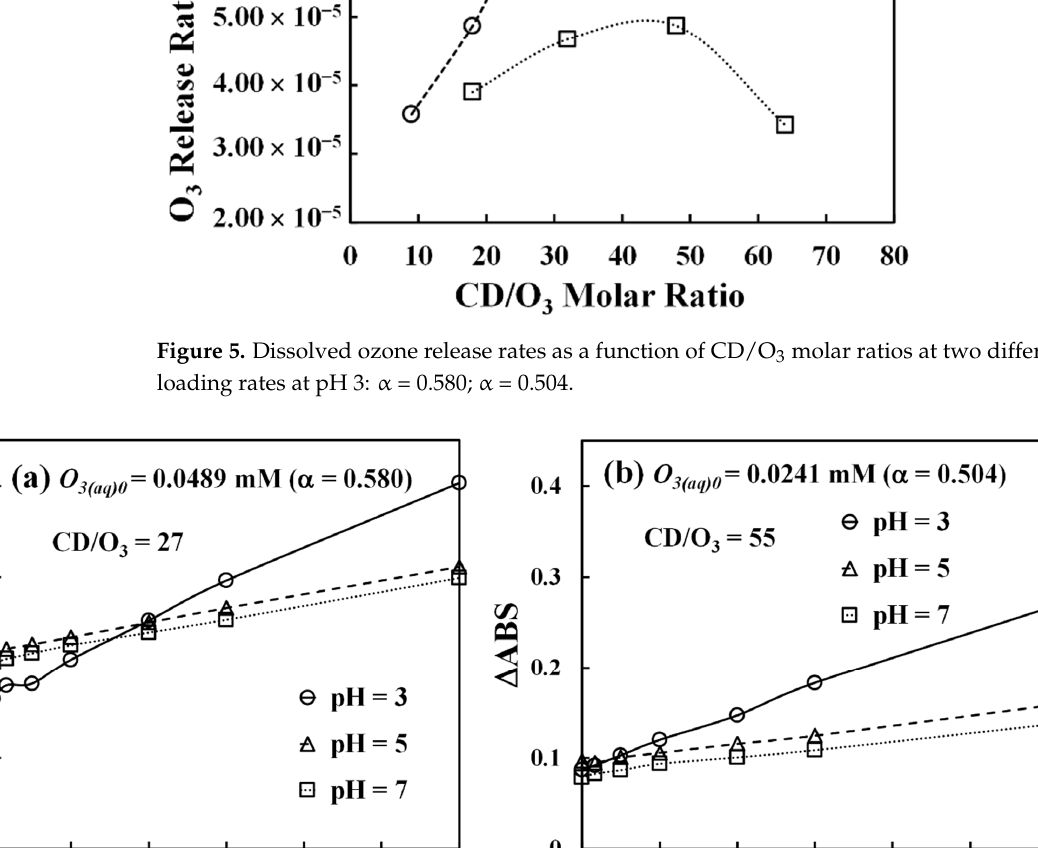
Figure 6. Comparisons of ozone release data at different pH values under two different α values and CD/O 3 molar ratios: ( a ) α = 0.580 and CD/O 3 molar ratios = 27; ( b ) α = 0.504 and CD/O 3 molar ratios = 55.